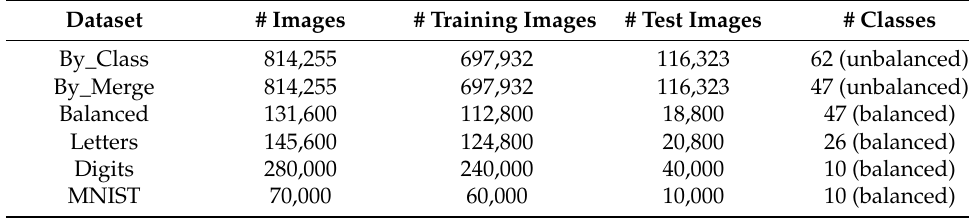
Table 2. Specification of the EMNIST classification